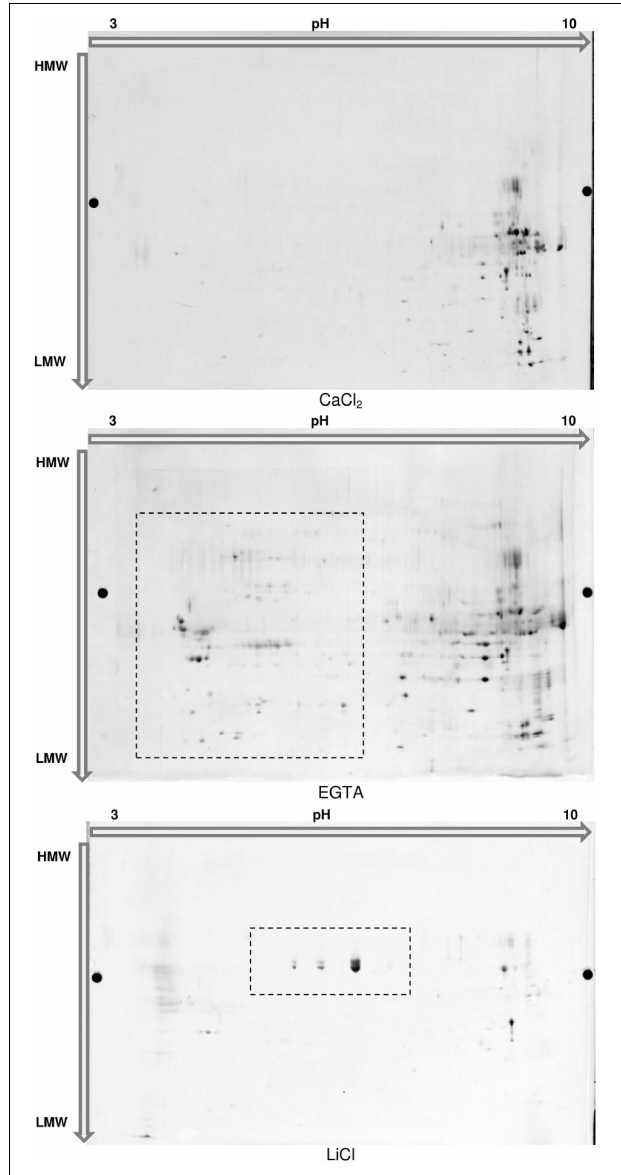
FIGURE 5 | 2D-Electrophoresis of the proteins extracted in each fraction of the hybrid protocol. Proteins were separated on Immobiline ™ DryStrip 3-10 NL, 24cm (GE Healthcare) and further migrated on 2D-HPE ™ Large-Gels NF 12.5% (Serva Electrophoresis GmbH). Proteins were post-stained with LavaPurple (Serva Electrophoresis GmbH).